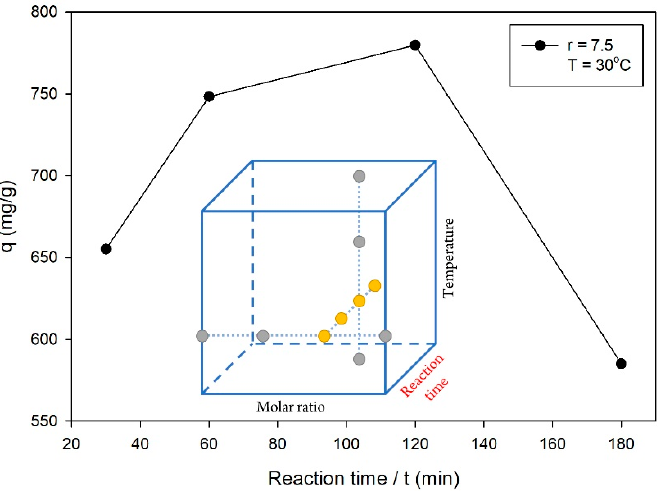
Figure 2. Effect of the reaction time on the 𝑞 value, with the following experimental conditions: Figure 3. Effect of temperature on the q value, with the following experimental conditions: molar molar ratio of ligand to metal = 7.5 and temperature = 30 ° C. ratio of ligand to metal = 7.5 and reaction time = 120